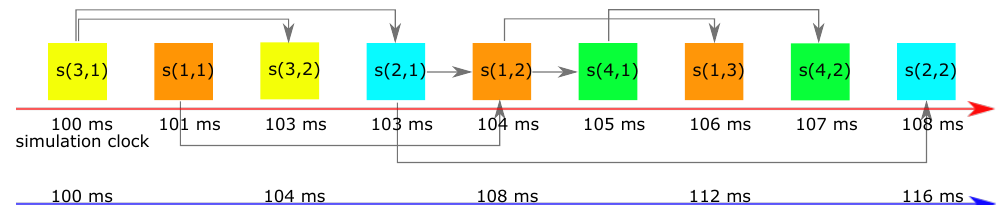
Figure 3. Artificial non-real-time-capable scenario in a standard DES